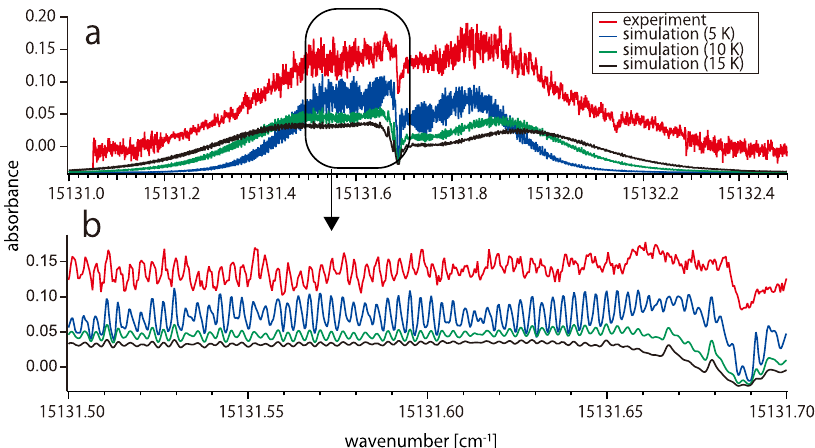
Fig. 2 Observed and simulated spectra of the 0 – 0 band of the S 1 – S 0 transition of FBPc. Panel a shows the wide overview spectra. The red line is the observed spectrum and others are tentative simulation results from PGOPHER 28 assuming the same rotational and translational temperatures. Panel b shows enlarged views of the spectra. Regular spectral oscillation due to rotational motion can be clearly seen.